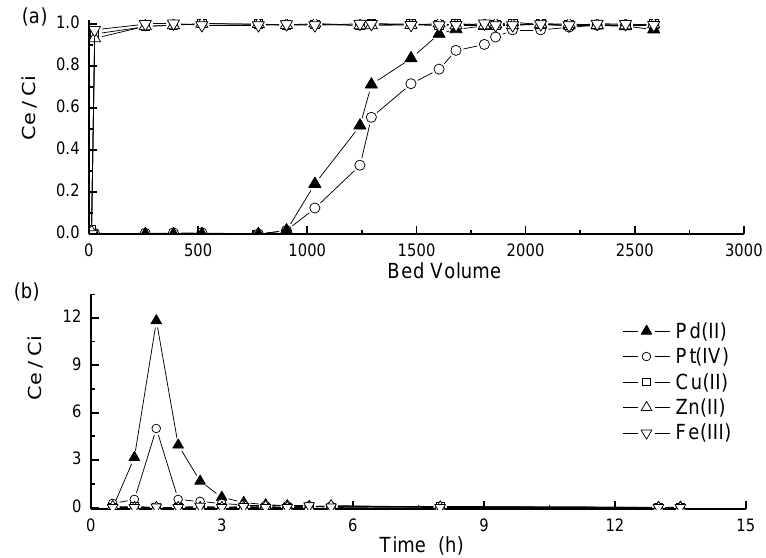
Figure 30. ( a ) Breakthrough profiles of various metal ions contained in the sample solution of the actual effluent of the precious metals industry from the first column column packed with CPW gel; ( b ) Elution profiles of various metal ions from the first column using aqueous mixture of 0.1 mol·dm −3 thiourea in 1 mol·dm −3 hydrochloric acid solution [36] (with permission for reuse from Elsevier B.V.).